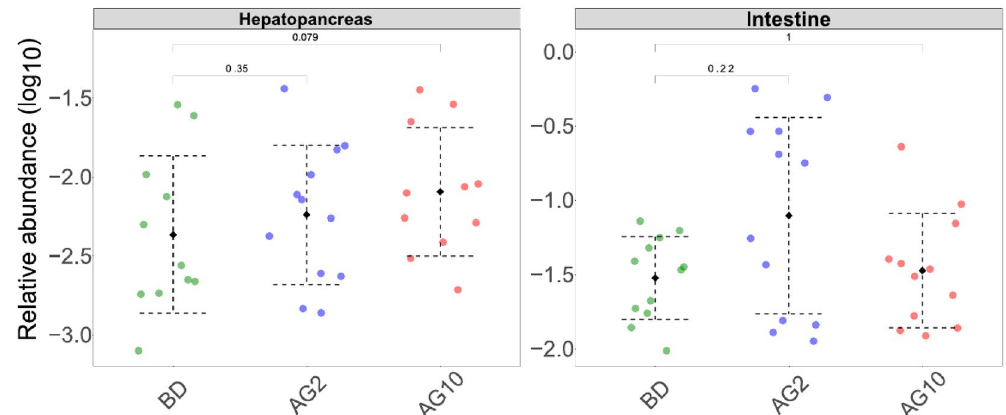
Figure 6 . Abundance of beneficial "meta-community" species by each organ and treatment. The boxplots shows the log10 of the sum of the relative abundance frequency of the beneficial microbes for each